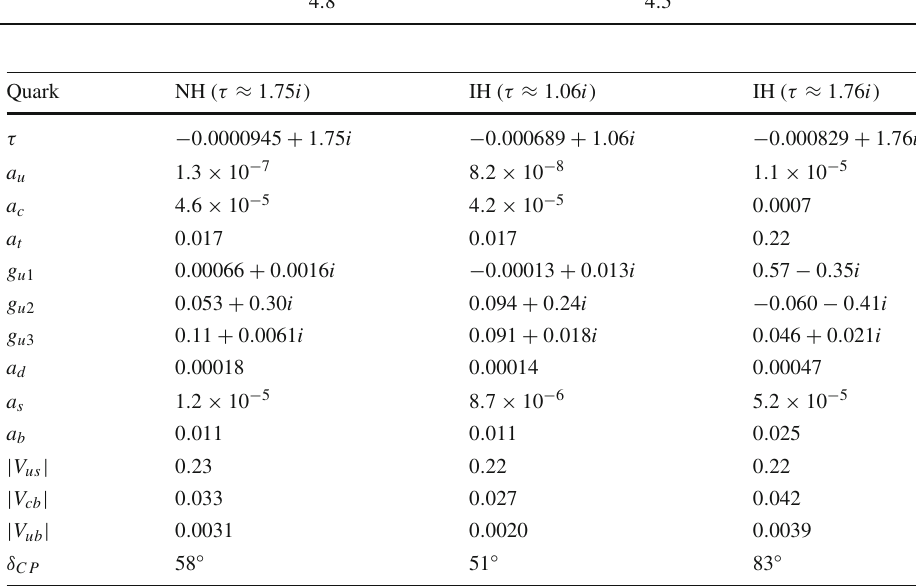
Table 4 Numerical values of parameters and observables at the best fit points of NH and IH